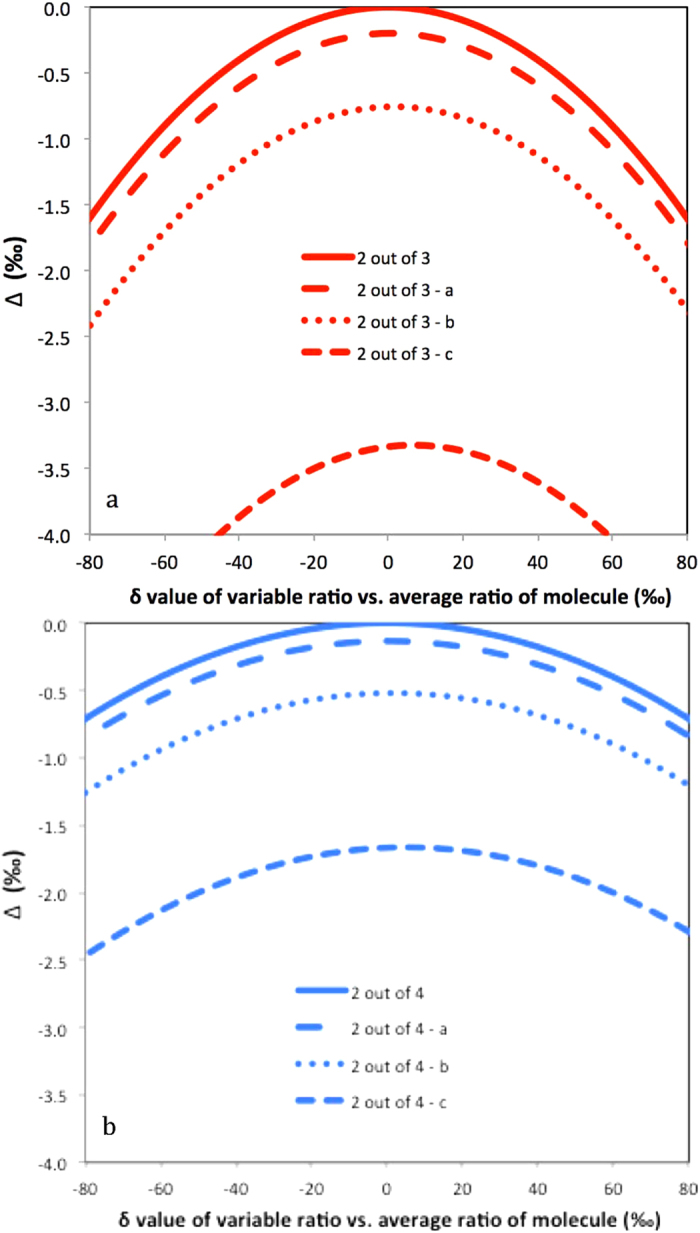
Statistical heavy isotope clumping of two out of three (a) and two out of four (b) heavy isotopes.In all cases shown, the isotope ratio of one atom is varied relative to the mean of the other ratios as indicated on the x axis and the other ratios are fixed. In the base case (solid line), the isotope ratios of the other atoms are identical. This includes the situation for which all isotope ratios are identical (Δ = 0‰), in case a (dashed line) one of the fixed isotope ratios is increased by 5%, in case b (dotted line) one of the fixed isotope ratios is increased by 10% and in case c (long-dashed line) one of the fixed isotope ratio is increased by 10% and another ratio is decreased by 10%.